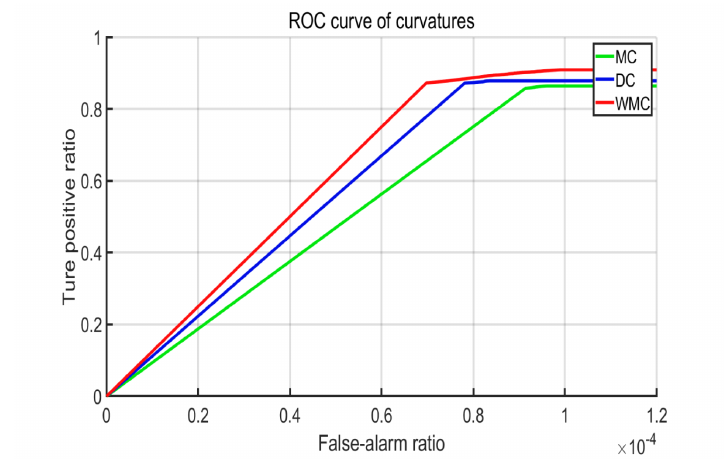
Figure 6. ROC curve of different curvatures.